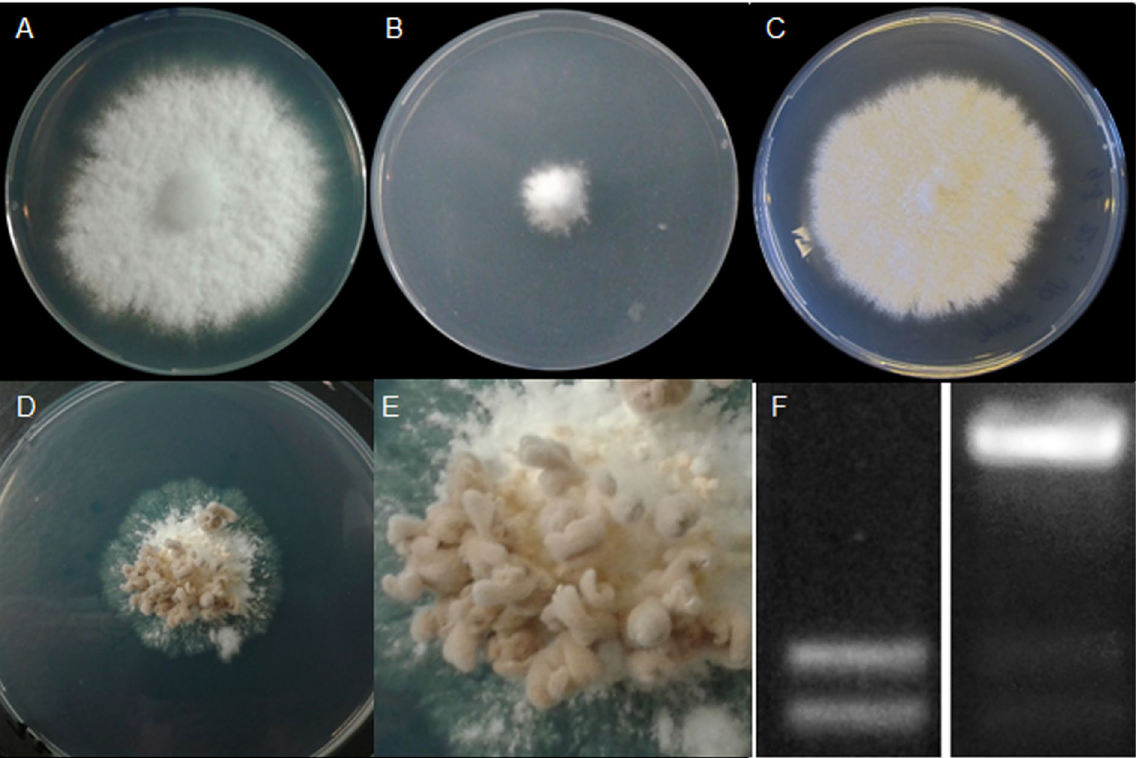
Figure 5. Six-day-old colonies of the wild type monokaryon ( A , C ) and a hom2 con strain ( B , D ) grown continuously at 30 °C in the dark at high CO 2 ( A,B ) or transferred to 25 °C, low CO 2 , and light ( C , D ). ( E ) represents a close up of fruiting bodies of the hom2 con strain, while ( F ) shows relative hom2 and hom2 con expression in wild-type (left) and the hom2 con strain T4